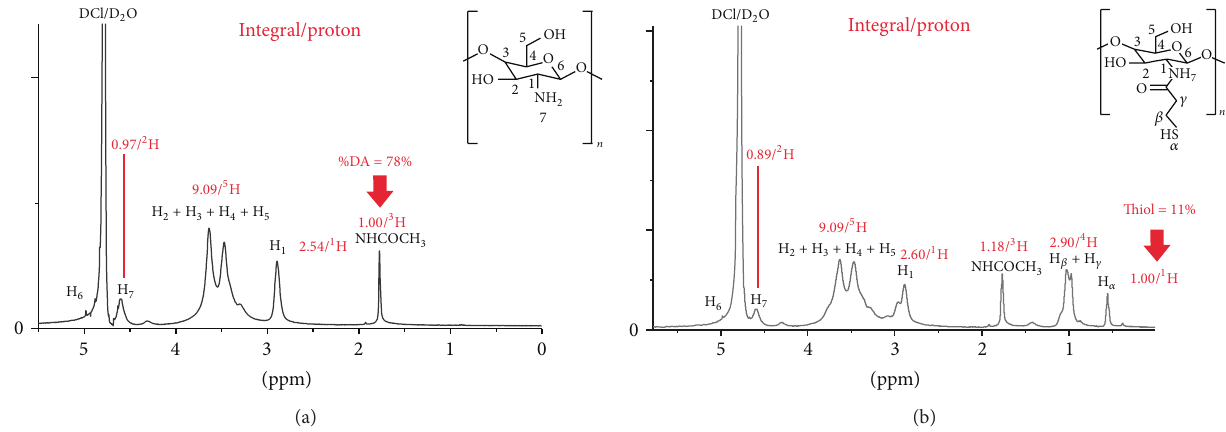
Figure 3: 1 HNMR spectra of native (a) and thiolated (b) chitosan in DCl/D 2